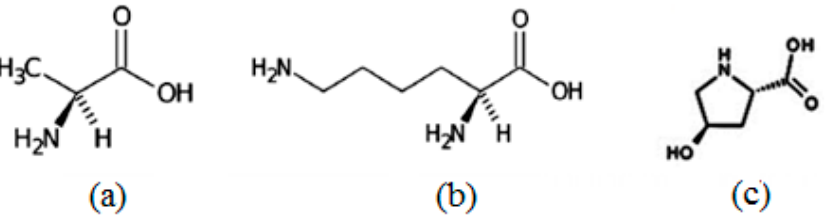
Figure 12. Molecular structure of ( a ) L-alanine, ( b ) L-lysine and ( c ) trans-4-hydroxy-L-proline.